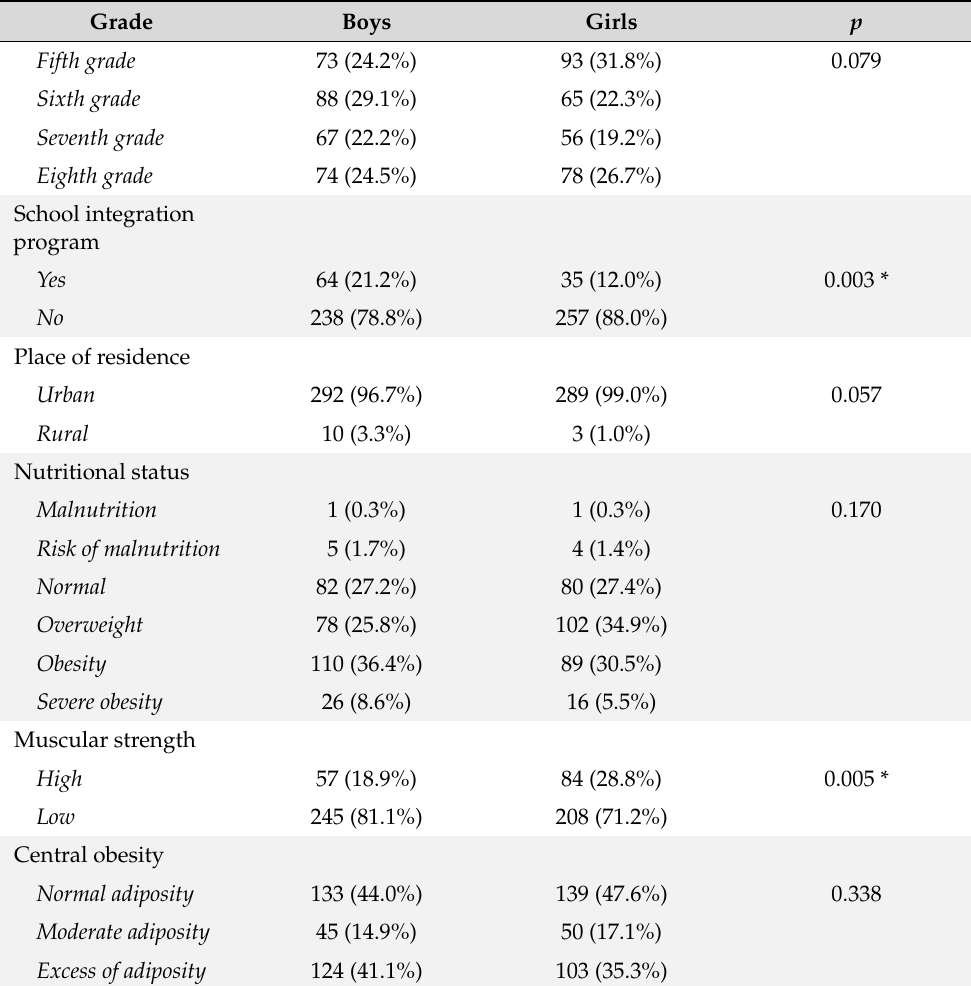
Table 1. Scholarship and health characteristics of the